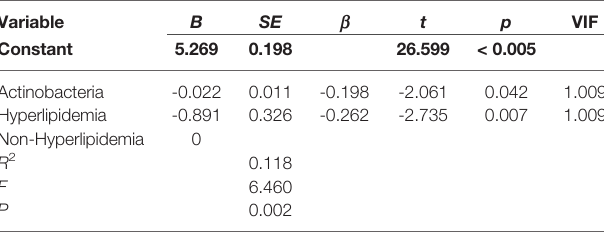
TABLE 2 | Linear regression analysis for Actinobacteria predicting FLC l .